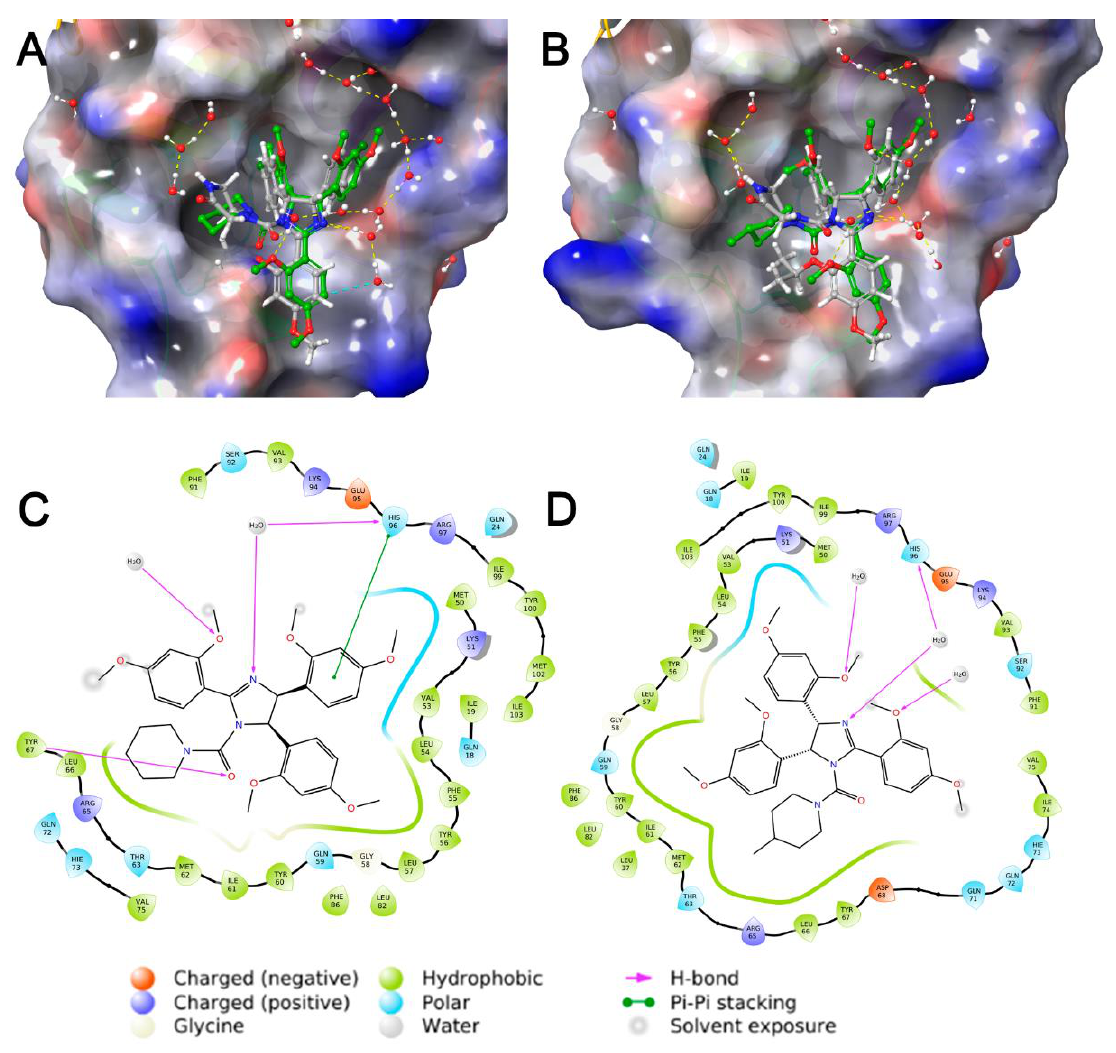
Figure 2. Docked poses for 2k ( A ) and 2l ( B ) (green), in p53 binding site of MDM2 protein, in comparison to nutlin-3a (grey). Ligand-protein interaction map for 2k ( C ) and 2l ( D ) in p53 binding site of MDM2 protein.